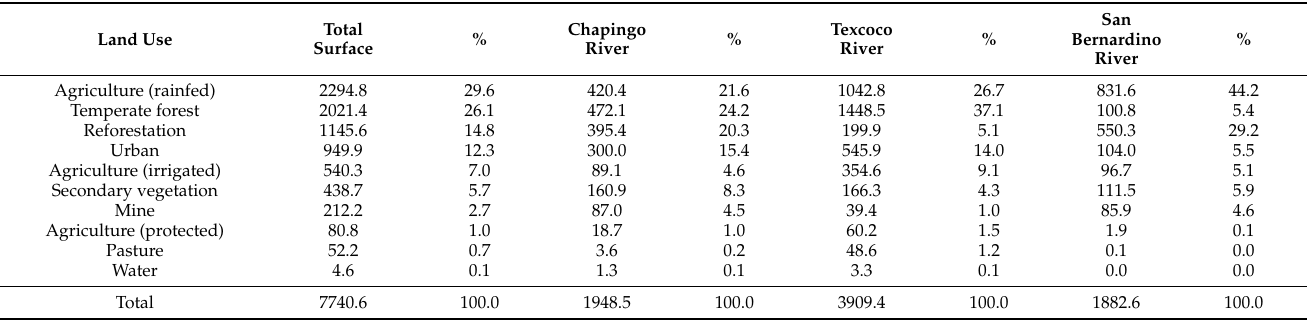
Table 1. Land use and occupied surface (hectares) in the studied micro-watersheds (based on Ruiz-Garc í a, 2022, [27]).